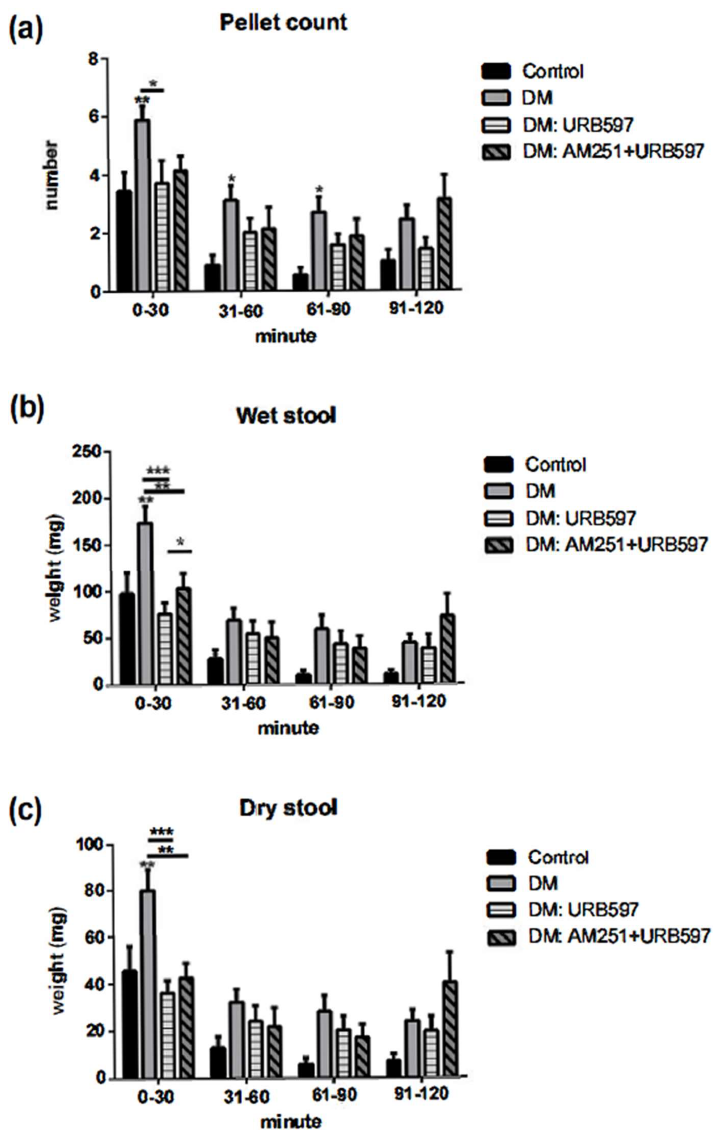
Figure 1. The effect of STZ-induced diabetes and URB597 (5 mg/kg, IP) on fecal output in mice. STZ significantly increased fecal pellet counts as well as wet and dry stool weights (** p ≤ 0.01 vs. control). URB597 reversed the effects of STZ in the discussed fecal parameters. AM251 (0.5 mg/kg, IP) did not block the effects of URB597. For each group, n = 5. Two-way ANOVA: F (3, 144) = 17.20, F (3, 144) = 19.26, and F (3, 144) = 16.16 for row factors in panels ( a–c ), respectively (ANOVA p ≤ 0.001 all panels) (underlined * p ≤ 0.05, ** p ≤ 0.01, *** p ≤ 0.001 vs. DM). DM bar indicates diabetic mice treated with vehicle.